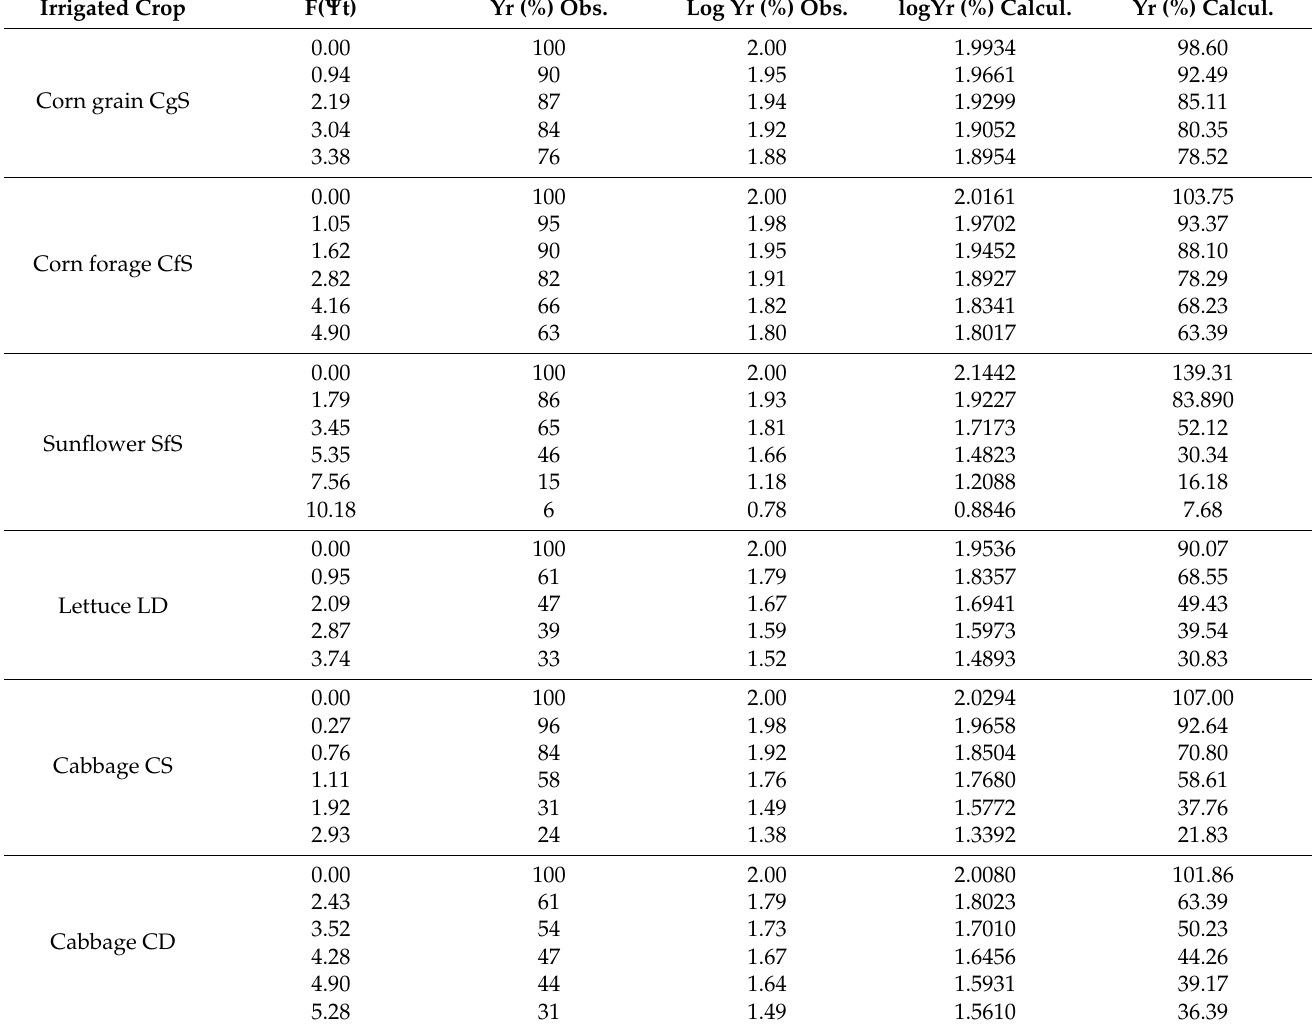
Table 7. Irrigated crops relative yield Yr (%) response to the function of the soil total water potential f( Ψ t). Irrigated Crop F( Ψ t) Yr (%) Obs. Log Yr (%) Obs. logYr (%) Calcul. Yr (%) Calcul.